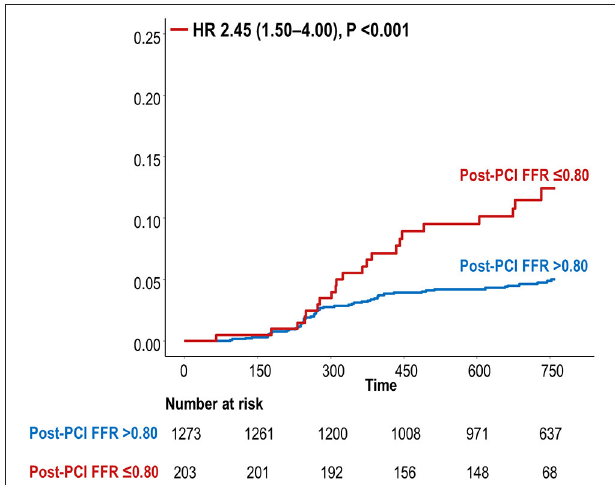
FIGURE 2 | Cumulative incidence of TVF at 2 years according to residual ischemia. FFR, fractional flow reserve; HR, hazard ratio; PCI, percutaneous coronary intervention; TVF, target vessel failure.